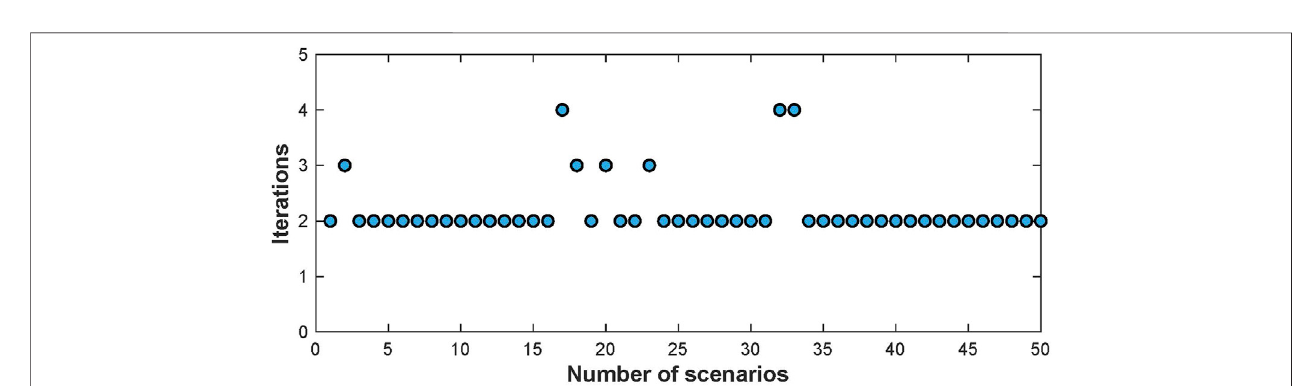
Frontiers in Energy Research |